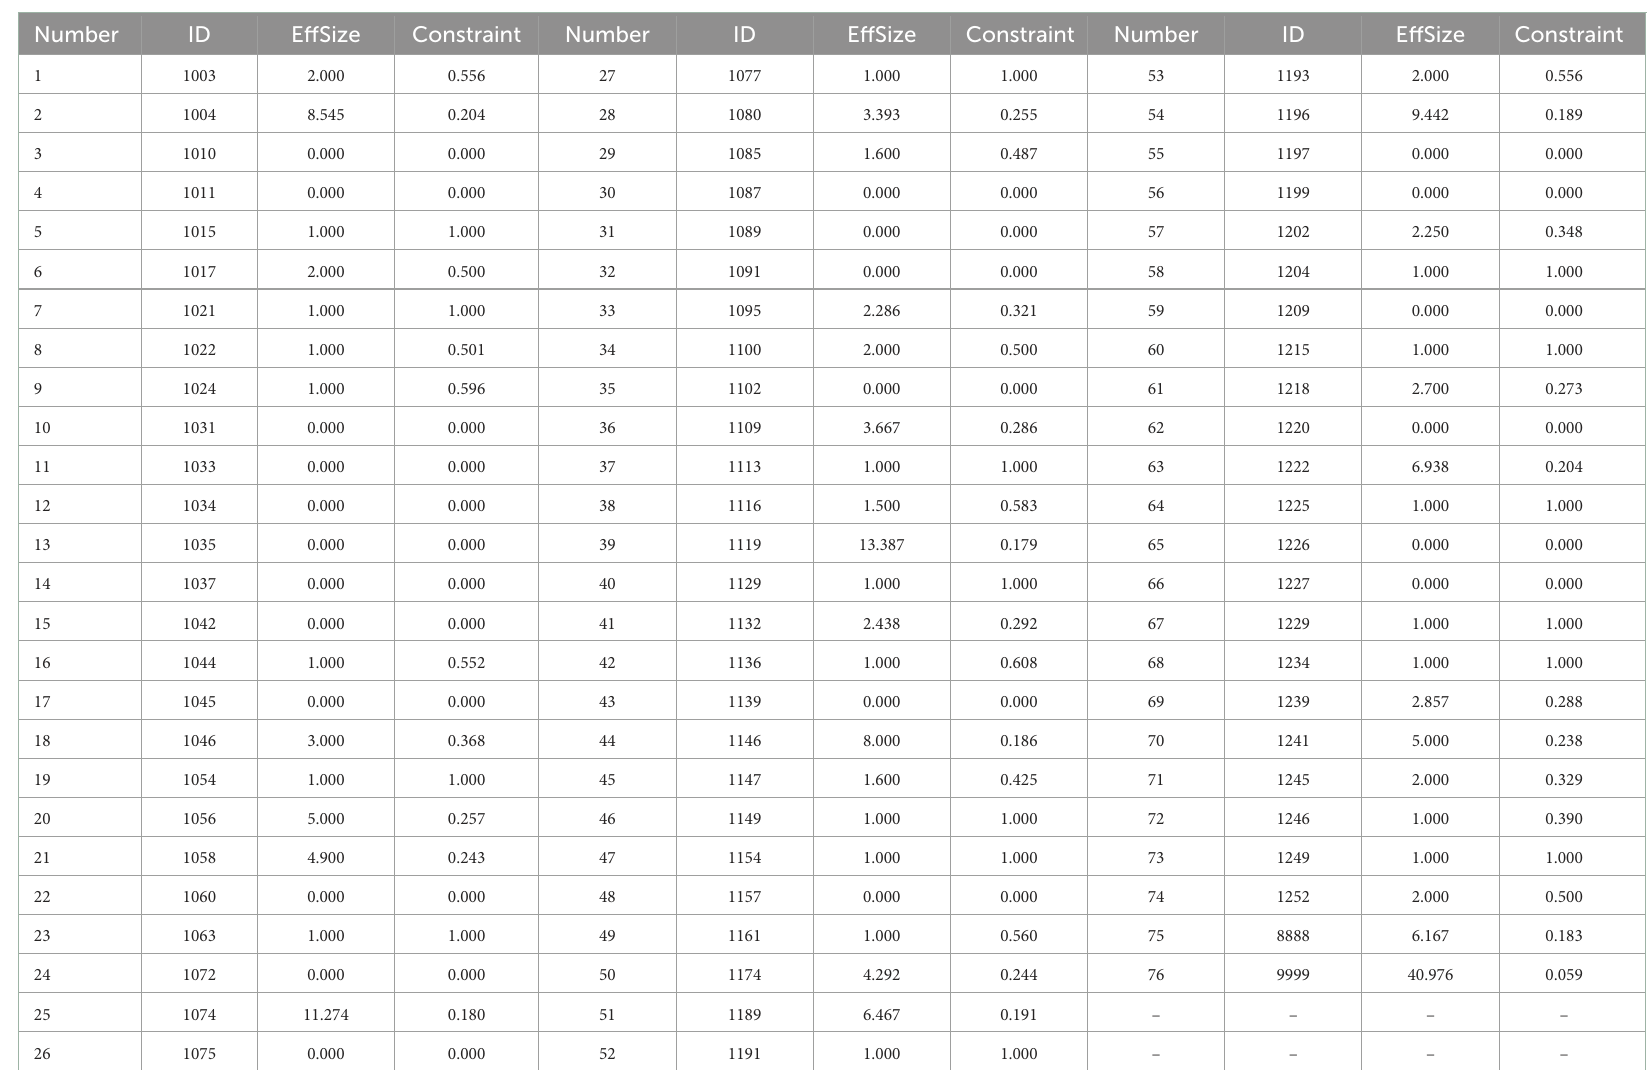
TABLE 6 The structural holes of intervention